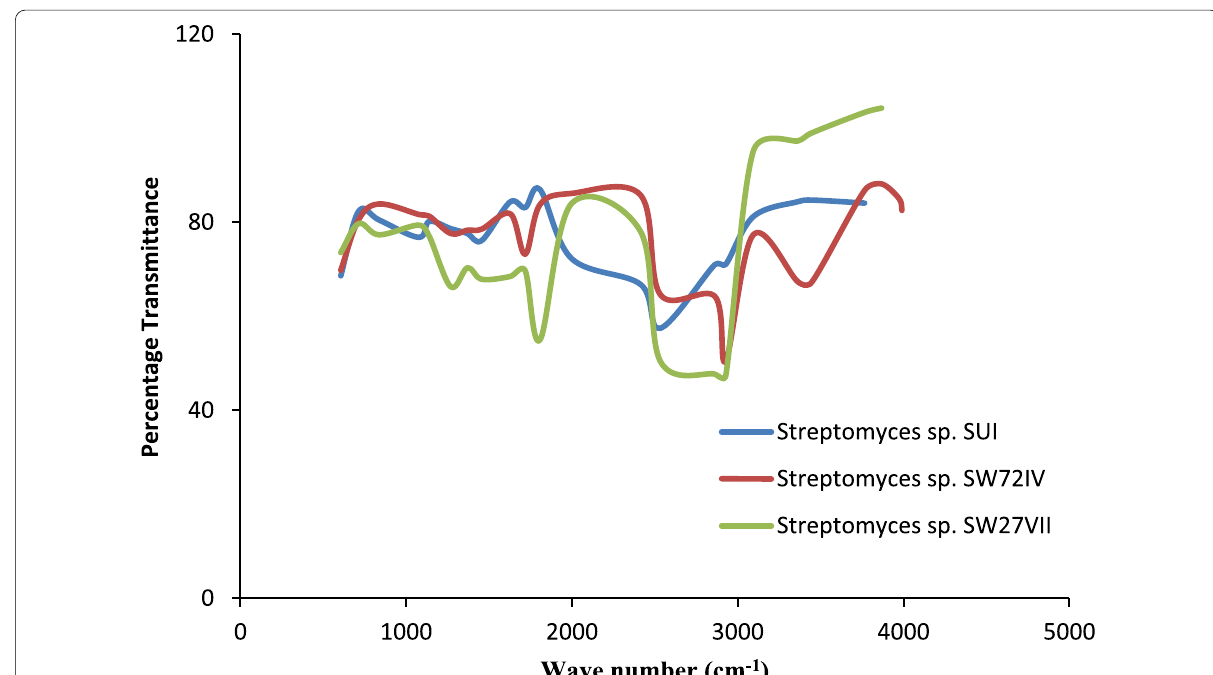
Fig. 4 IR spectra of bioactive compounds synthesized by Streptomyces sp. SUI, Streptomyces sp. SW72IV and Streptomyces sp.